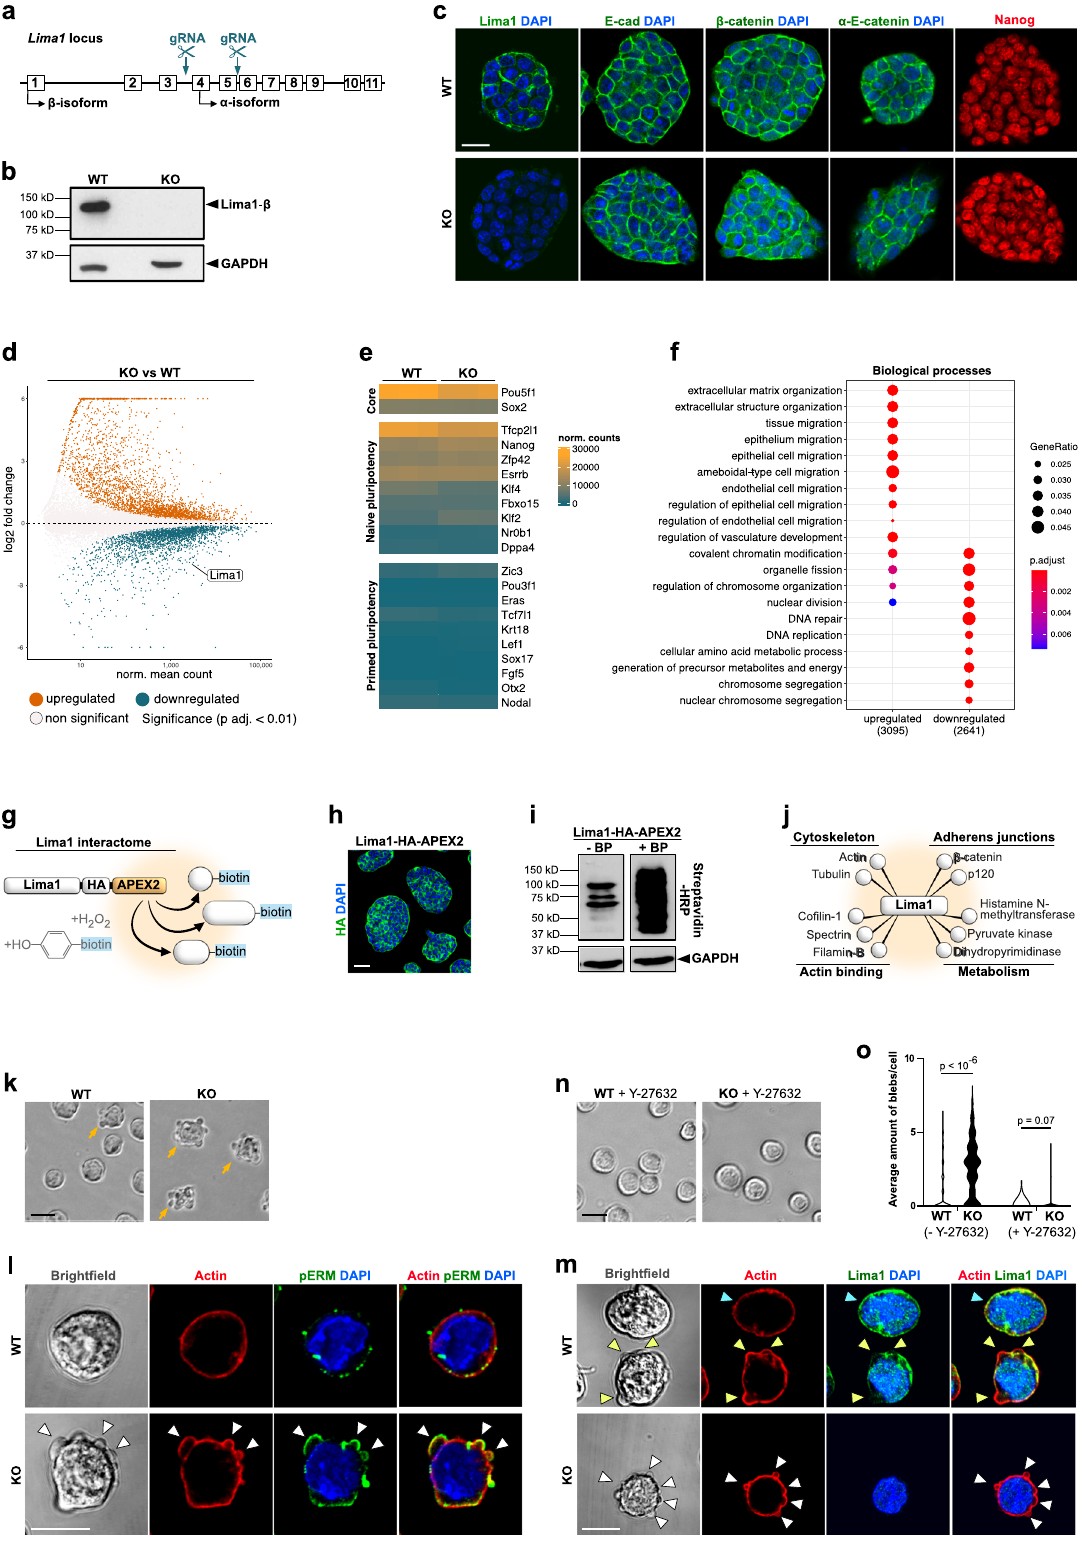
(Y-27632) has been shown to supress the blebbing of primed pluripotent cells 42,43 . Accordingly, Y-27632 treatment also diminished blebbing in Lima1 KO ESC (Fig. 3n, o). Altogether, this shows that Lima1 acts as an effector molecule downstream of membrane dynamics in